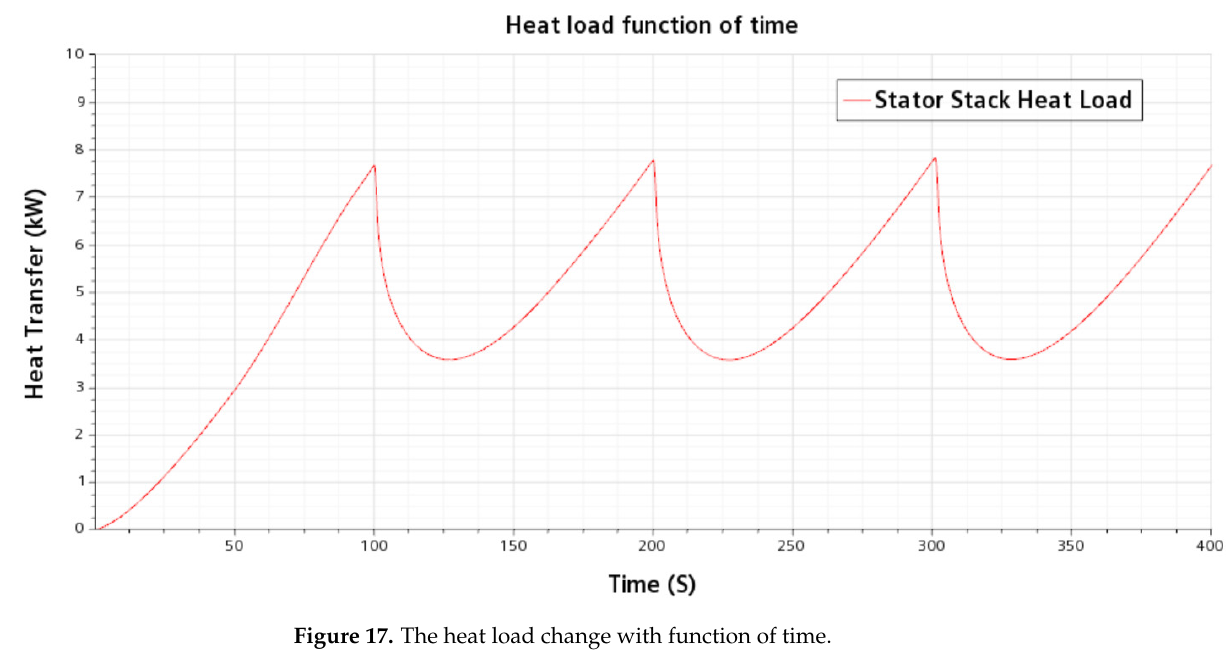
Figure 16. The comparison of heat capacity of different rib configuration.